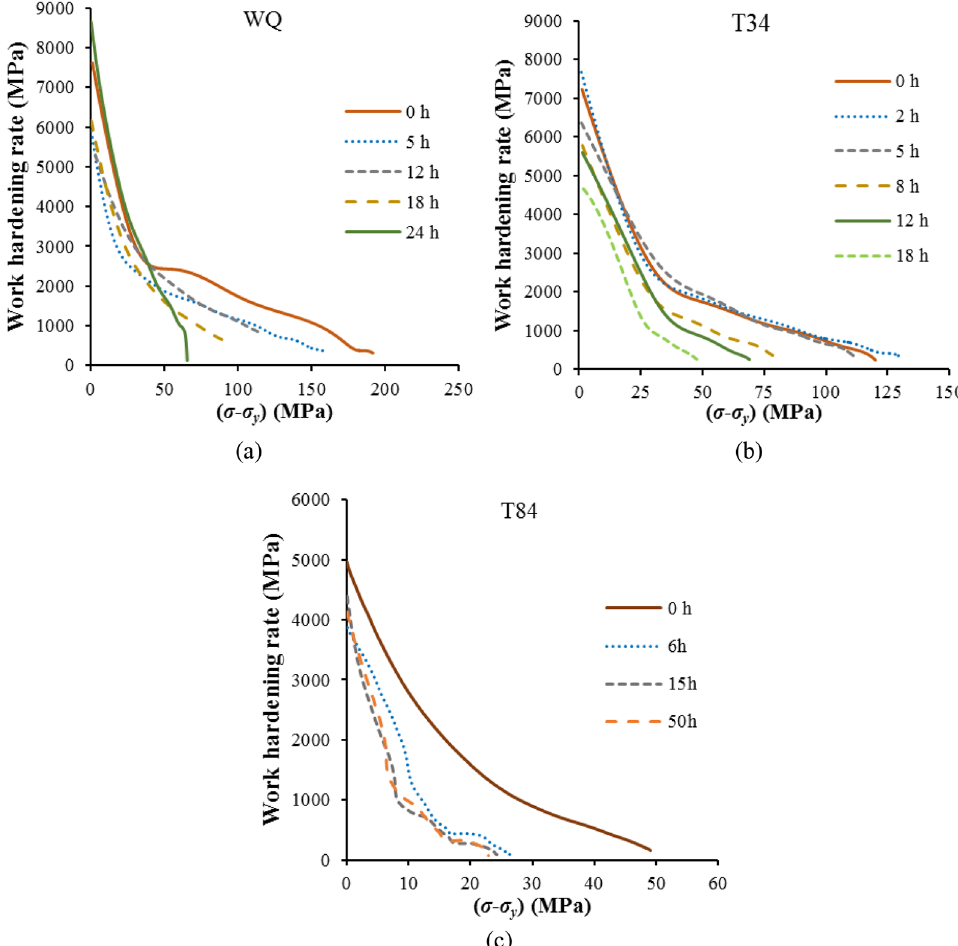
Fig. 8. Evolutions of work hardening rates with the hardening strength ( s – s y ) for AA2050 with (a) WQ, (b) T34 and (c) T84 initial tempers creep-aged under 150 MPa at 155 ° C for indicated